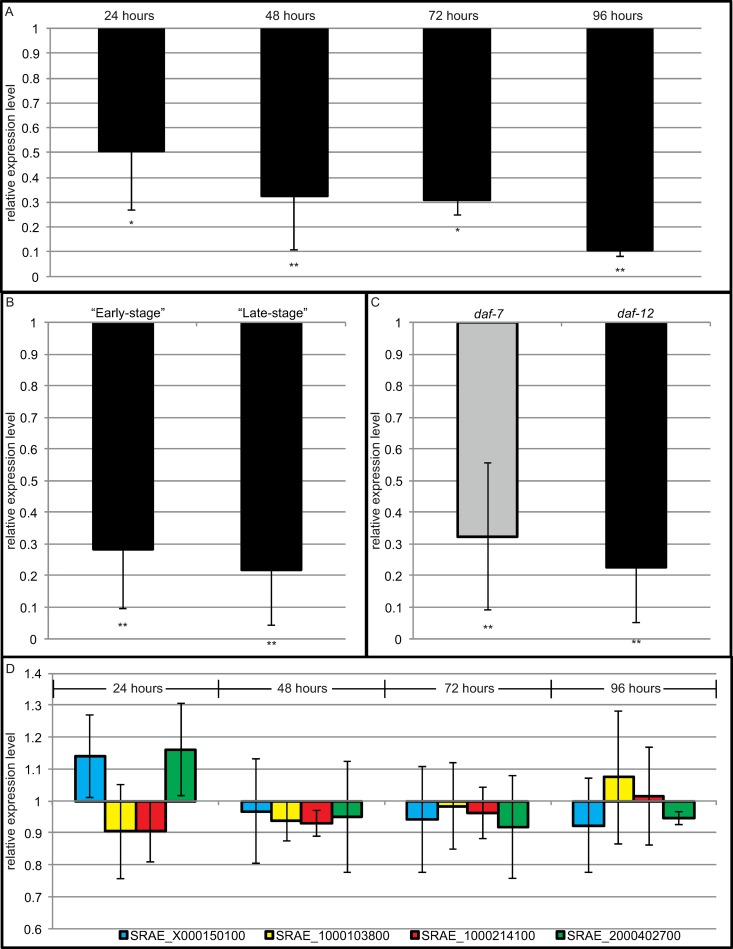
RNAi-mediated suppression within Strongyloides ratti.RNAi reduces expression of daf-12 with statistically significantly increased reduction in daf-12 as length of soaking increases (relative gene expression of 0.51 ± 0.24 after 24 hours (p = 0.01), 0.32 ± 0.22 after 48 hours (p<0.001), 0.31 ± 0.06 after 72 hours (p = 0.01) and 0.11 ± 0.03 after 96 hours (p<0.001) (A), with both the “Early-stage” (relative gene expression 0.28 ± 0.19 (p<0.001)) and “Late-stage” soaking protocols (relative gene expression 0.22 ± 0.18 (p<0.001)) (B) resulting in a reduction following 48 hours of soaking. The “Late-stage” technique can be to achieve a statistically significant reduction in expression in both daf-7 (in grey) (relative gene expression 0.32 ± 0.23 (p<0.001)) and daf-12 (in black) (0.23 ± 0.17 (p<0.001)) (C), with minimal off-target effects detected across five genes with a similarity to an siRNA targeting daf-12 in S. ratti over different time points (relative expression of SRAE_X000150100 was 1.14 ± 0.13 after 24 hours, 0.97 ± 0.16 after 48 hours, 0.94 ± 0.17 after 72 hours and 0.92 ± 0.15 after 96 hours. Relative expression of SRAE_1000103800 was 0.90 ± 0.15 after 24 hours, 0.94 ± 0.06 after 48 hours, 0.98 ± 0.14 after 72 hours and 1.07 ± 0.21 after 96 hours. Relative expression of SRAE_1000214100 was 0.94 ± 0.17 after 24 hours, 0.98 ± 0.14 after 48 hours, 0.96 ± 0.08 after 72 hours and 0.92 ± 0.16 after 96 hours. Relative expression of SRAE_2000402700 was 0.92 ± 0.15 after 24 hours, 1.07 ± 0.21 after 48 hours, 1.02 ± 0.15 after 72 hours and 0.95 ± 0.02 after 96 hours (no statistically significant reduction in any of genes at any of the time points)) (D). S. ratti larvae were soaked using either the “Early-stage” protocol (B) or “Late-stage” protocol (A-D) and then the relative expression level of the targeted gene was determined using qRT-PCR compared to 3 control genes with a scrambled siRNA used as a control. Error bars represent standard deviation. These figures show the mean value comprised of a minimum of 3 biological replicates with 3 technical replicates per biological replicate. Mann Whitney U analysis was performed to determine statistical significance. * indicates a statistically significant difference (p-value ≤0.01 - ≥0.001), ** indicates a highly statistically significant difference (p-value ≤0.001).